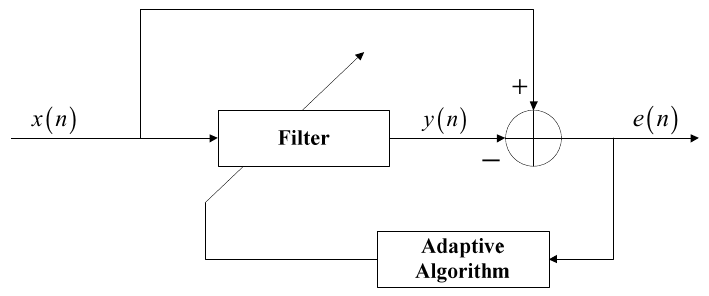
Figure 3. Time-domain anti-jamming filter structure. Common adaptive algorithms for time-domain anti-jamming include the Least Mean Square (LMS) algorithm based on the Minimum Mean Square Error (MMSE) criterion and the Least Squares (LS) algorithm based on the Recursive Least Squares (RLS) algorithm.